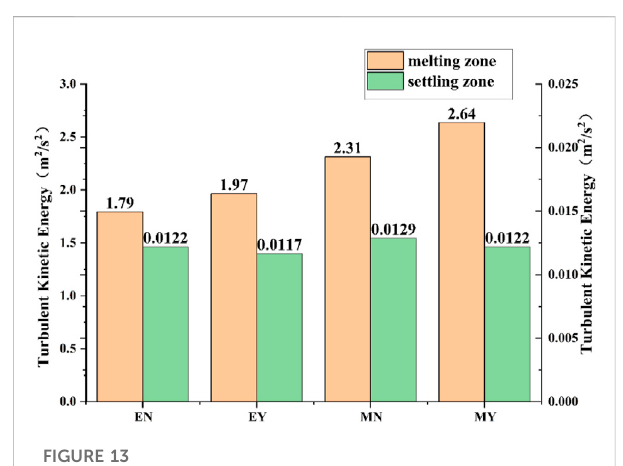
FIGURE 13 Comparison of average turbulent kinetic energy in melting zone and settling zone at 3 s in four